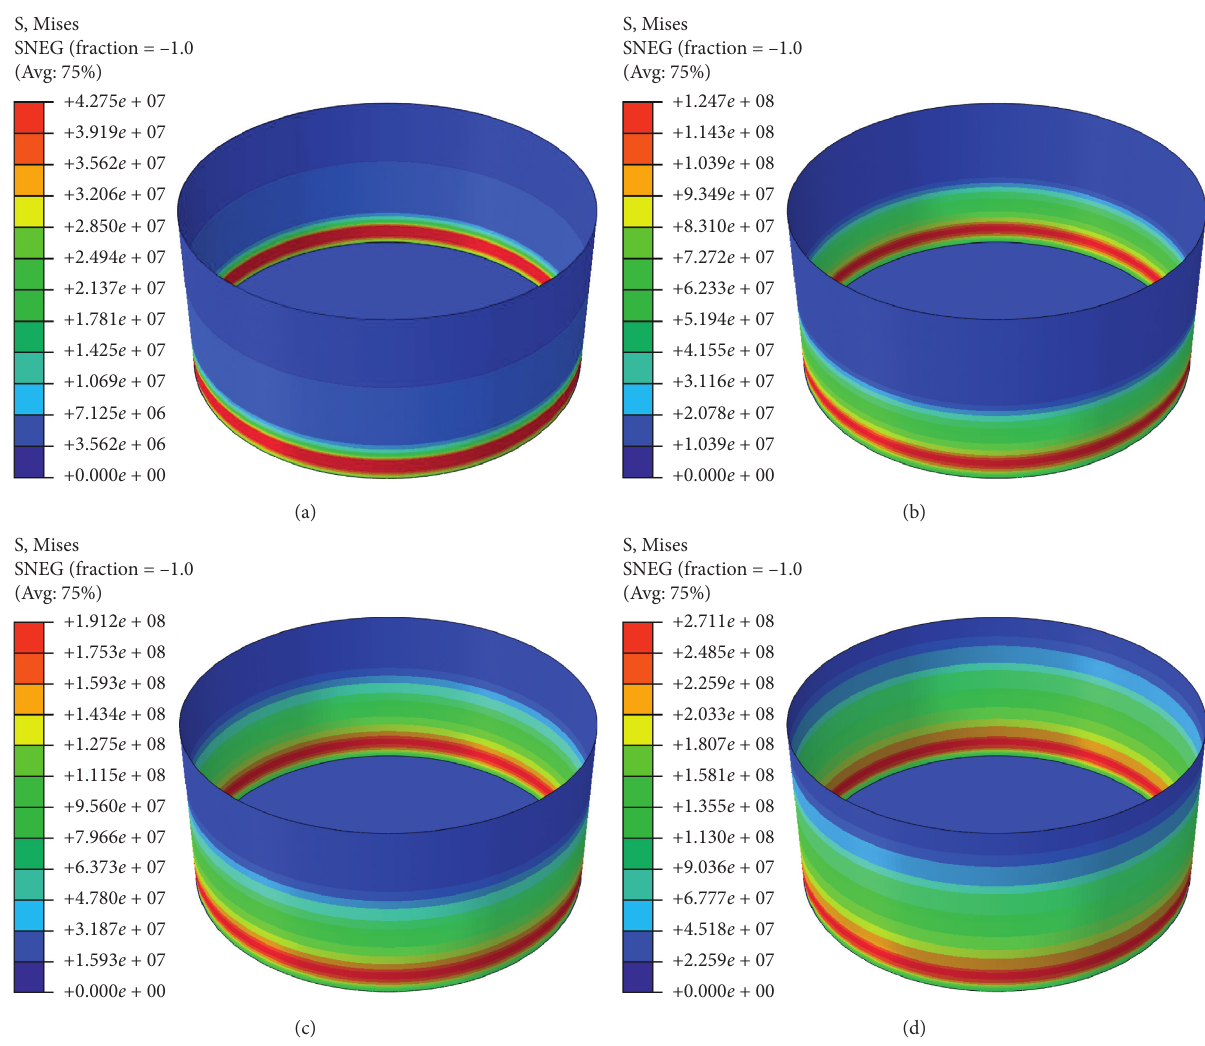
Figure 9: Distribution of von Mises stress distribution on the inner tank under static conditions at different LNG liquid levels. (a) At 25% full, (b) at 50% full, (c) at 75% full, and (d) at 100%